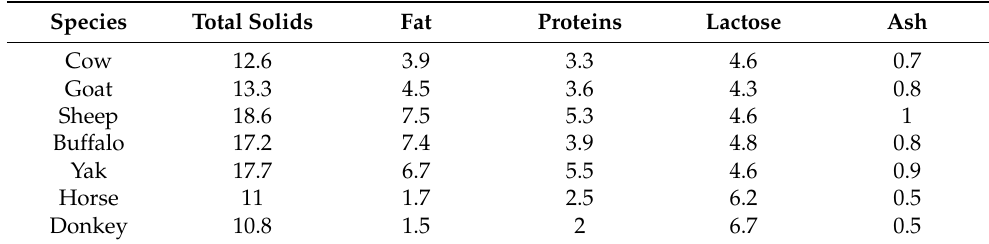
Table 1. Mean percentage composition (% w/w ) of milks from different species that are used for the production of fermented dairy products.